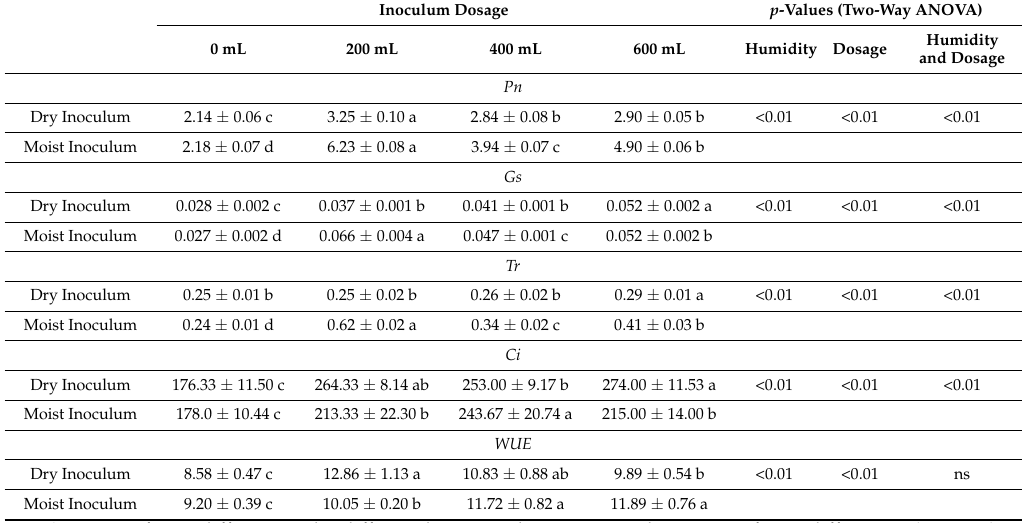
Table 4. Effects of EMC treatment on gas exchange parameters of P. tabuliformis under field conditions: four inoculated treatments (0, 200, 400, and 600 mL) with dry sterilized inoculum; four inoculated treatments (0, 200, 400, and 600 mL) with moist sterilized inoculum. Inoculum Dosage p -Values (Two-Way ANOVA) 0 mL 200 mL 400 mL 600 mL Humidity Dosage Humidity and